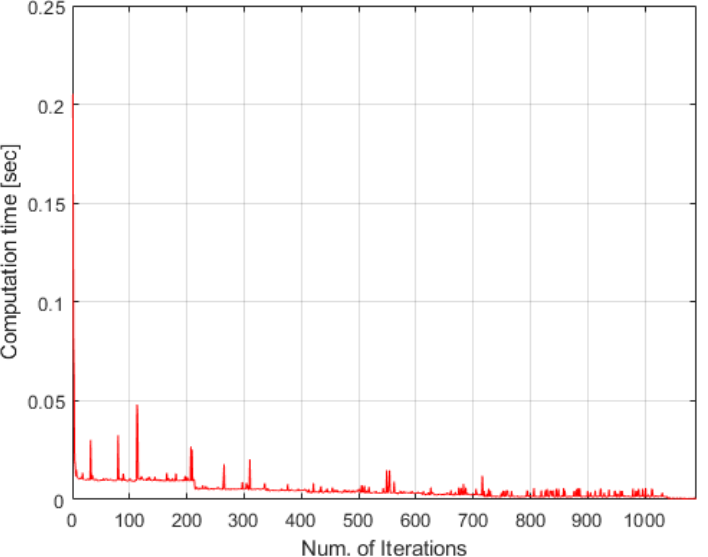
Figure 8. Computational time of TACTAR for a complicated case applying a modified time-dis- counted reward scheme.